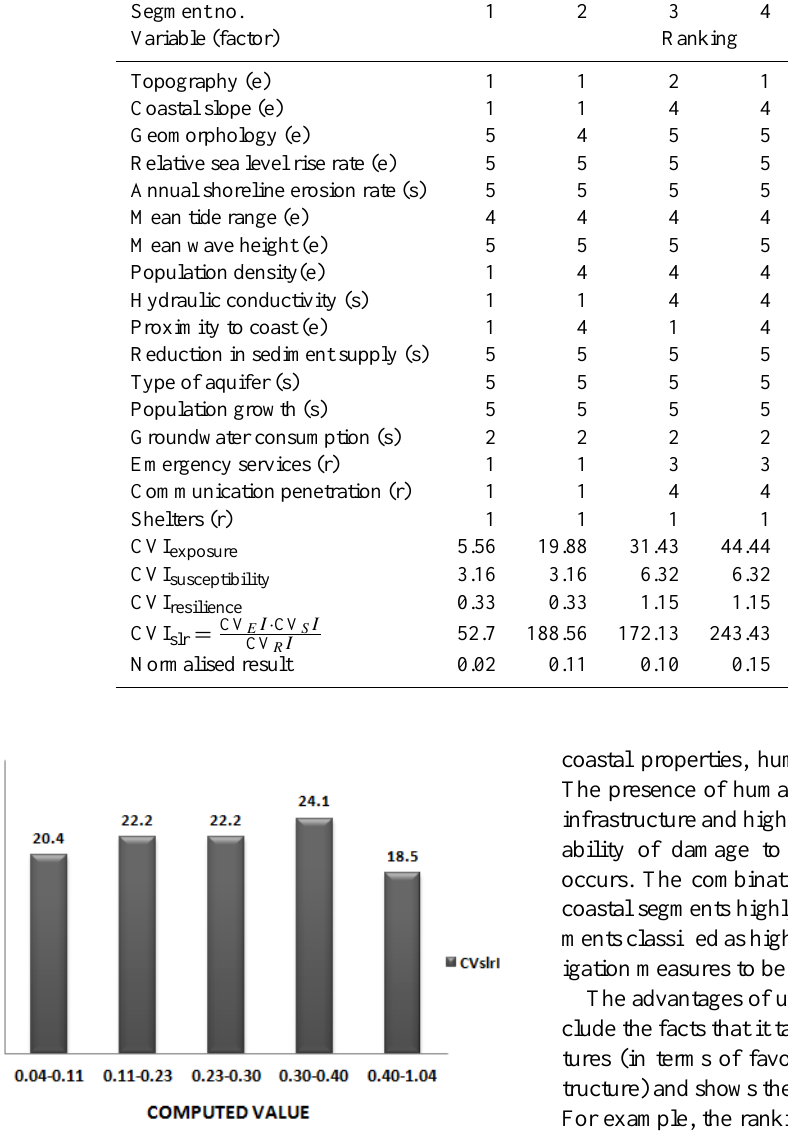
Figure 5. SLR CVI